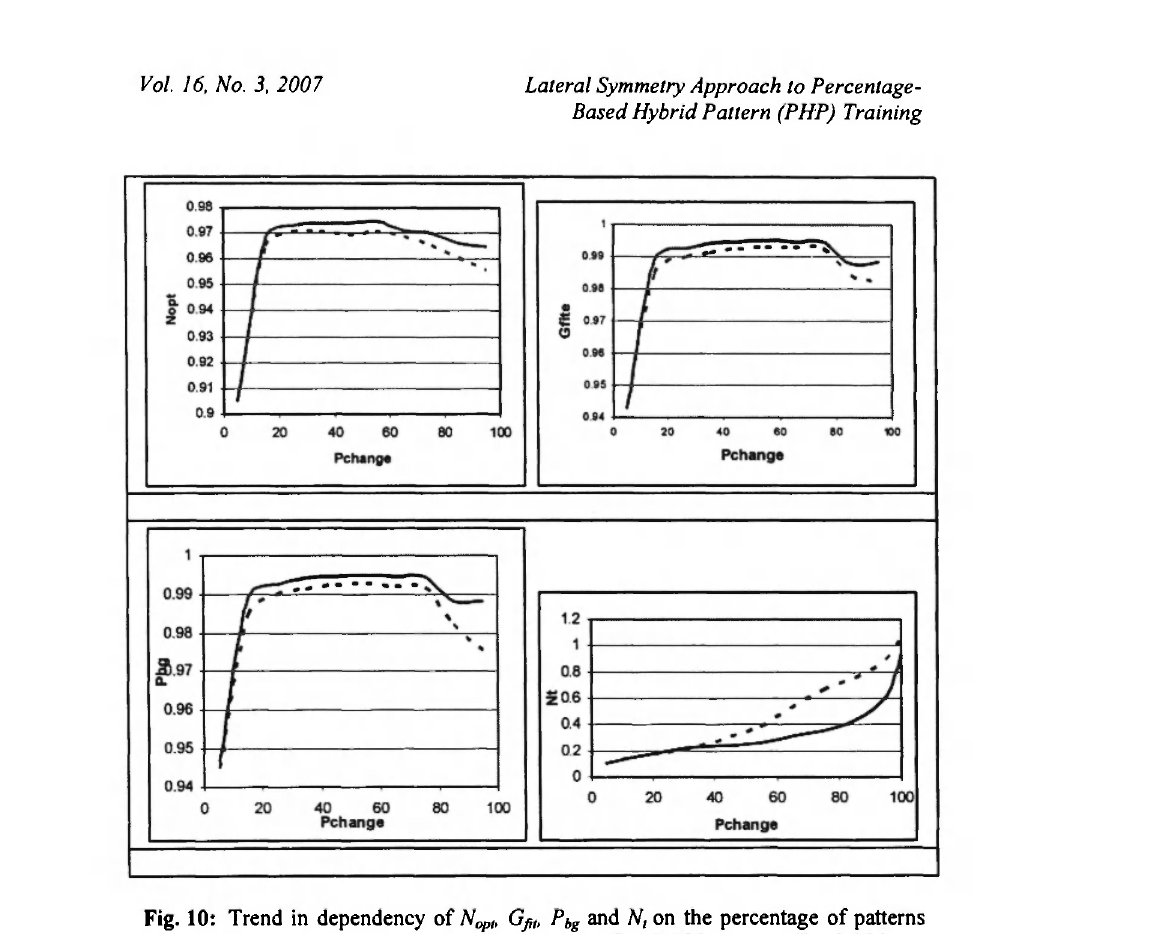
Fig. 10: Trend in dependency of N opl , G fi „ P bg and N, on the percentage of patterns learnt using global training. Key: ξ = 0.5% ξ = 1.0%